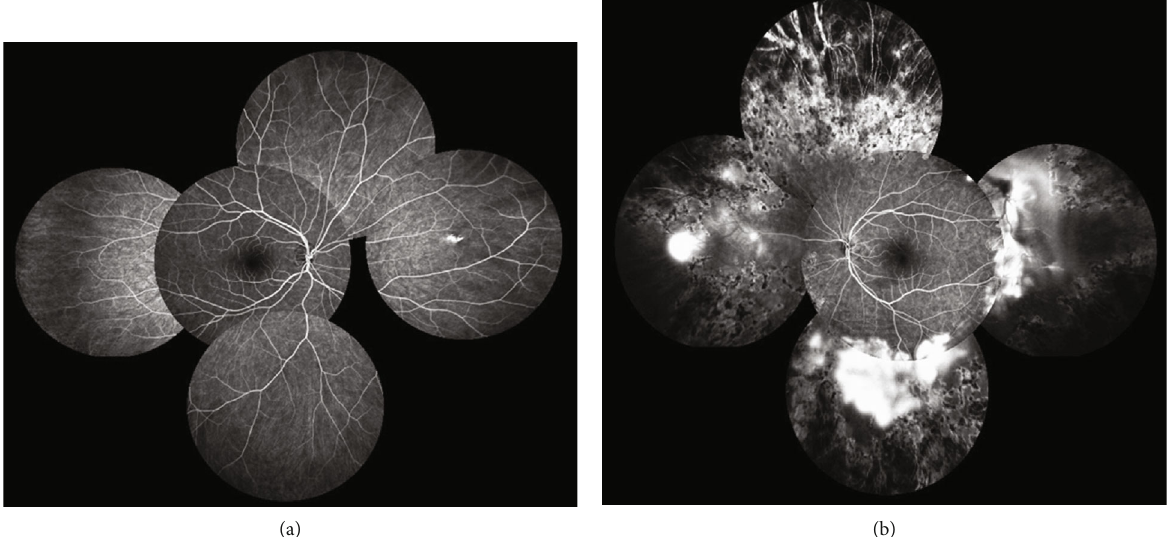
Figure 5: Montage midphase fl uorescein angiography of the right eye (a) showed unremarkable fi ndings but in the left eye (b) revealed residual peripheral avascular area, laser scars, and partially regressed neovascularizations corresponding to the leakage